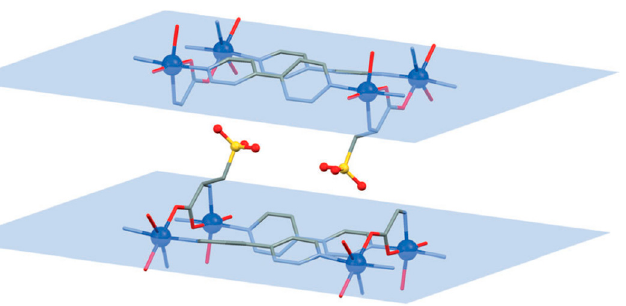
Figure 6. The mercury diagram showing 2D rectangular grids in 2D CCB. Reproduced with permis- sion from [105]. sion from